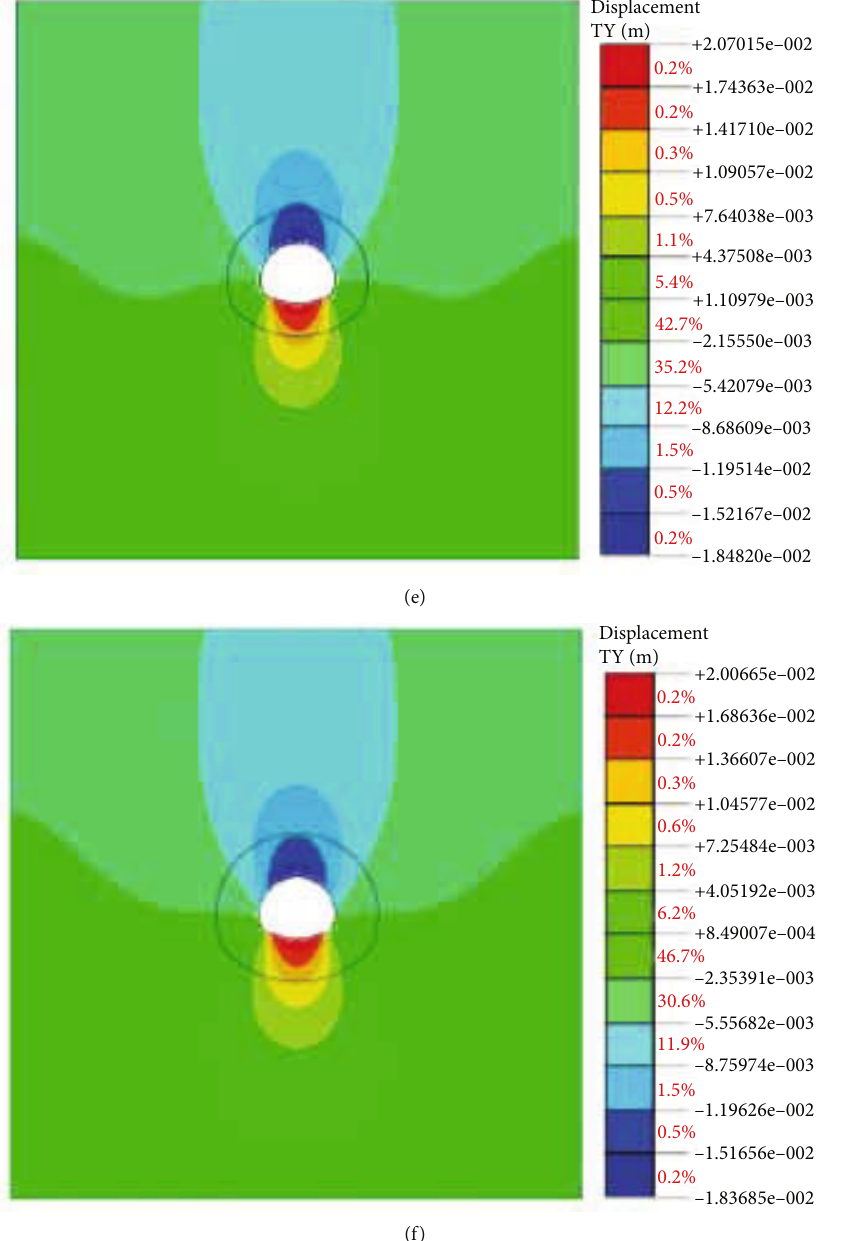
Figure 7: Vertical displacement cloud of the tunnel: (a) no grouting, (b) grout 1m, (c) grout 3 m, (d) grout 5 m, (e) grout 7m, and (f) grout